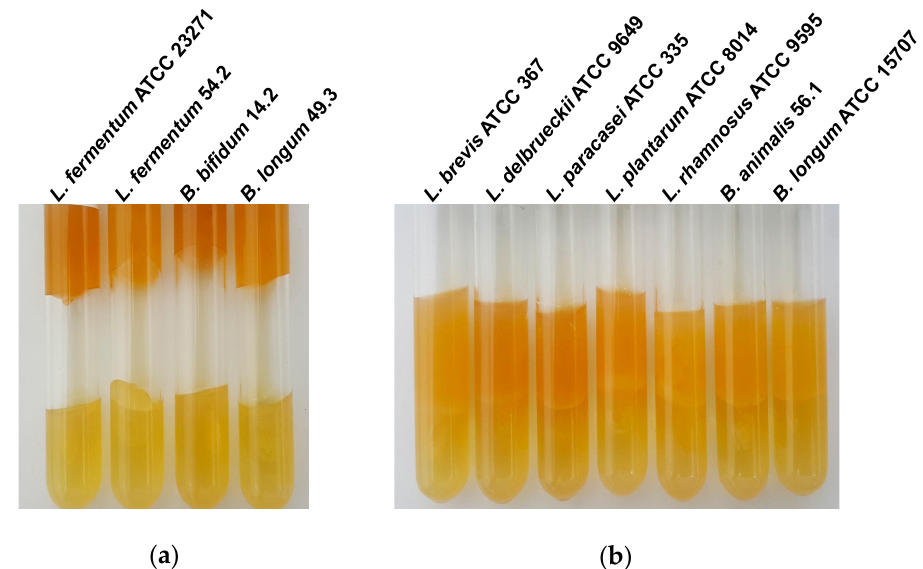
Figure 1. Inhibition of gas production assay. The lower layer corresponds to the RCM agar inoculated with Clostridium butyricum ATCC 860 and the upper layer is MRS medium with 0.7% agar and 100 mM phosphate buffer inoculated with Bifidobacterium and Lactobacillus strains; cultures were incubated at 37 ◦ C for 24 h under anaerobic conditions. ( a ) Gas production by C. butyricum in buffered MRS medium, indicating the absence of inhibitory activity of Lactobacillus and Bifidobacterium strains. ( b ) Inhibitory activity of five Lactobacillus and two Bifidobacterium strains on gas production by Clostridium butyricum . Table 2. Inhibition of gas production by C. butyricum induced by probiotics grown in MRS medium with and without phosphate buffer. Strains Without Buffer With